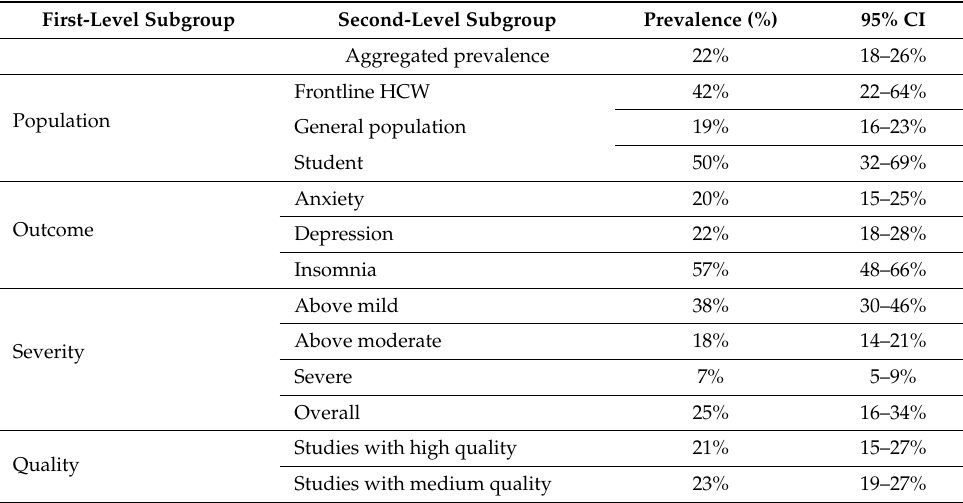
Table 2. The pooled prevalence rates of mental health symptoms by subgroups of population, outcome, and severity.